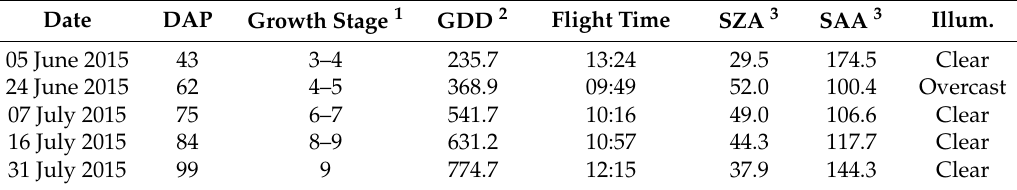
Table 1. Characteristics of the UAV data collected over time. Days after planting (DAP), estimate potato growth stage (according to the BBCH scale [27,28]), growing degrees day (GDD; using 7 ◦ C as base temperature), flight time (UTC +2), Sun zenith angle (SZA), Sun azimuth angle (SAA), and illumination